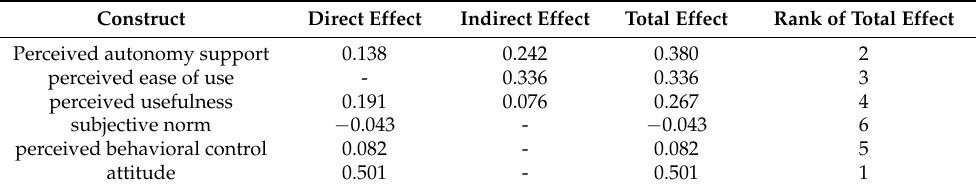
Figure 2. The Final Model and Path Coefficients. Note: * Significant at 0.05 level. ** Significant at 0.01 level. *** Significant at 0.001 level. Table 5. Direct, Indirect and Total Effects Analysis